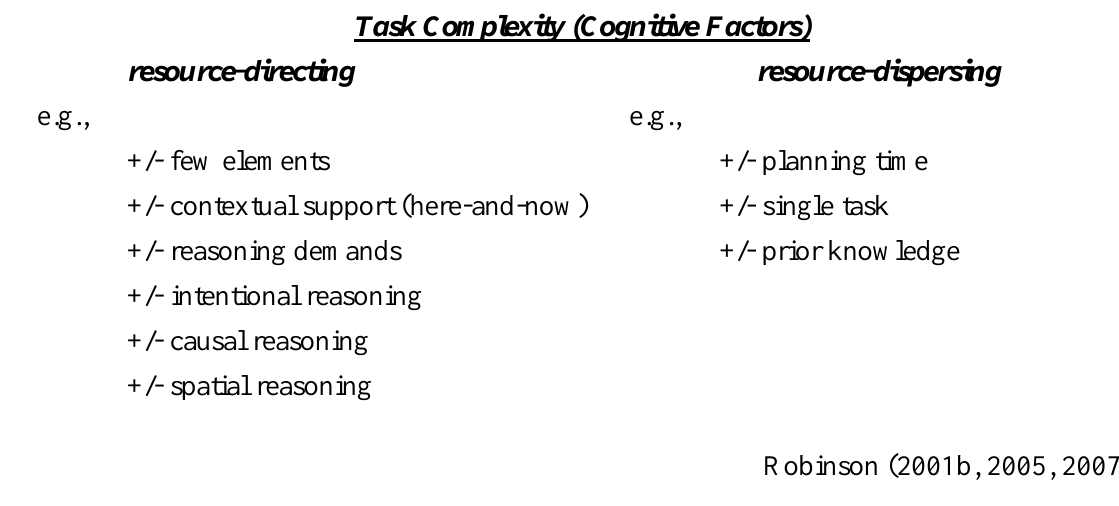
Resource-directing and Resource-dispersing Dimensions of Task